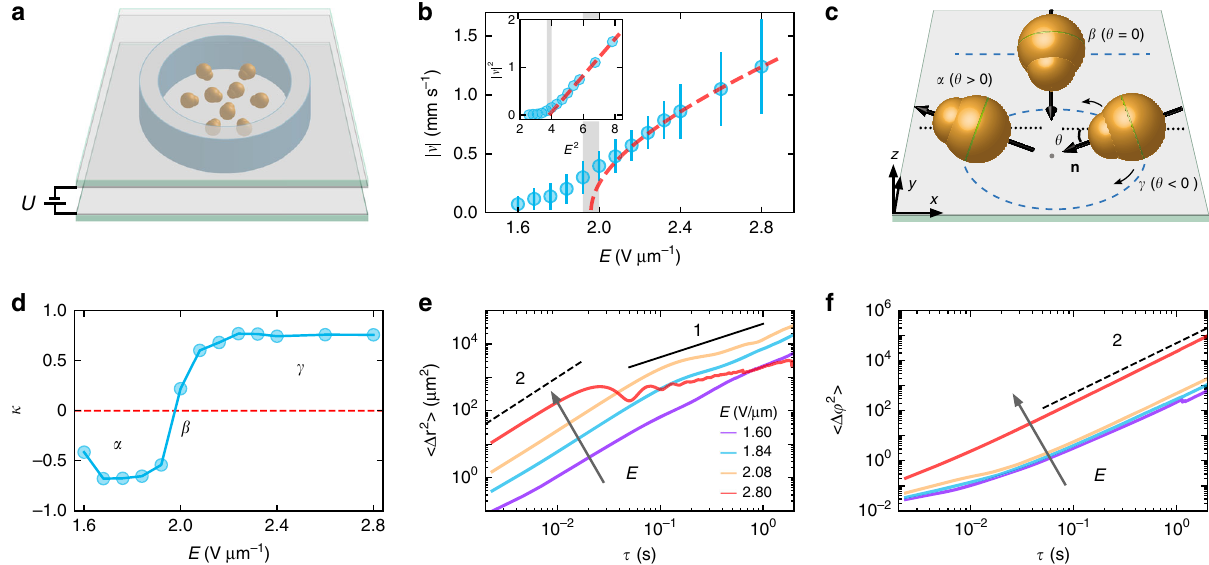
Fig. 1 Individual particle dynamics of pear-shaped Quincke rollers. a Schematics of the experiment: pear-shaped particles are con fi ned in a cylindrical well. A uniform DC electric fi eld is applied normal to the bottom surface of the cell. b Rolling velocity of the pear-shaped particles as a function of the electric fi eld strength E . Shaded area is a crossover region between two different modes of particles rolling. The red dash line is a fi t of the high fi eld part of ffiffiffiffiffiffiffiffiffiffiffiffiffiffiffiffiffiffiffiffiffiffi q ð E = E Þ 2 (cid:3) 1 the curve to j v j (cid:2) dependence typical for spherical rollers. E c = 1.96 V μ m − 1 . Insert, ∣ v ∣ 2 versus E 2 . Error bars are standard deviation of the c absolute values of velocities. c Three rolling modes of a pear-shaped particle: α ( θ > 0), β ( θ = 0) and γ ( θ < 0). Blue dash lines illustrate corresponding trajectories. d Trajectory curvature parameter, κ , as a function of the electric fi eld strength. Two distinctive modes of rolling correspond to α mode- ‘ heads- out ’ ( κ < 0) and γ mode- ‘ heads-in ’ ( κ > 0) regimes of particles propulsion. e Time evolution of the mean square displacement of pear-shaped Quincke rollers shown for a set of driving electric fi eld strengths. f Mean square angular displacements of pear-shaped rollers. In e – f black solid line has a slope of 1 and black dash lines have slopes of 2. In b , e – f area fractions of rollers are